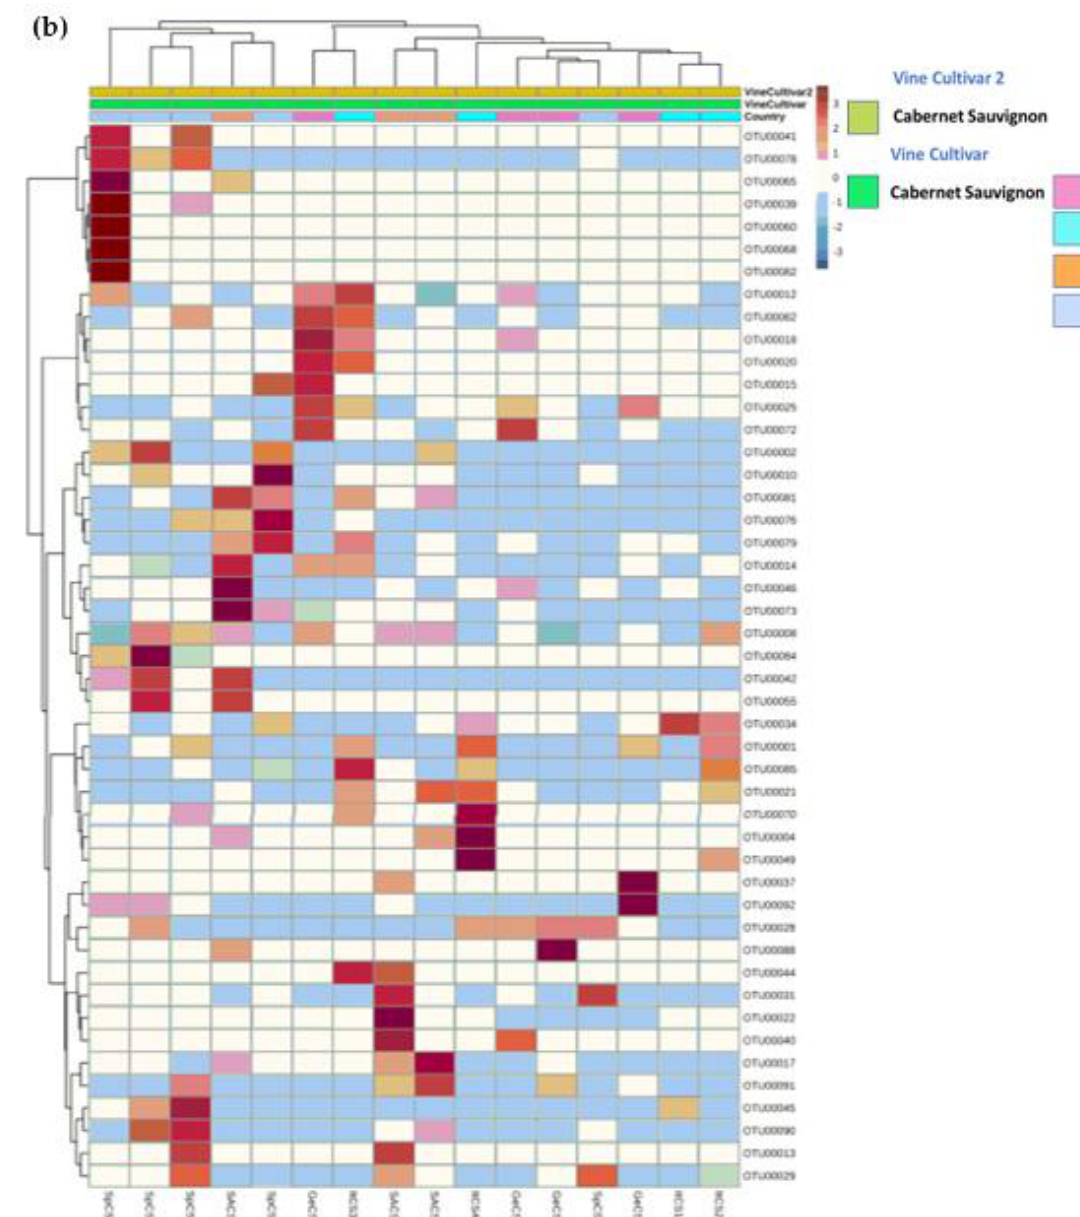
Figure A3. Clustered heatmap showing the variation of taxonomic abundance with regard to ( a ) local varieties of group vine cultivar samples and countries; ( b ) Cabernet Sauvignon cultivar samples and countries. Sample code: Ge, Georgia; It, Italy; SA, South Africa; Sp, Spain; CS, Cabernet Sauvignon.